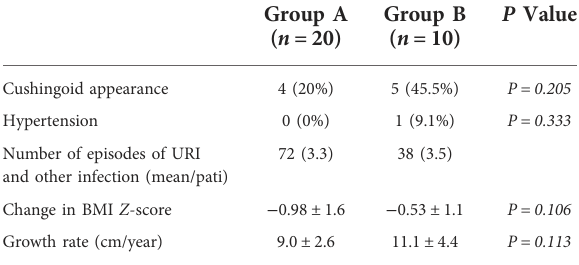
TABLE 4 Adverse events and growth in quick and slow responder groups.